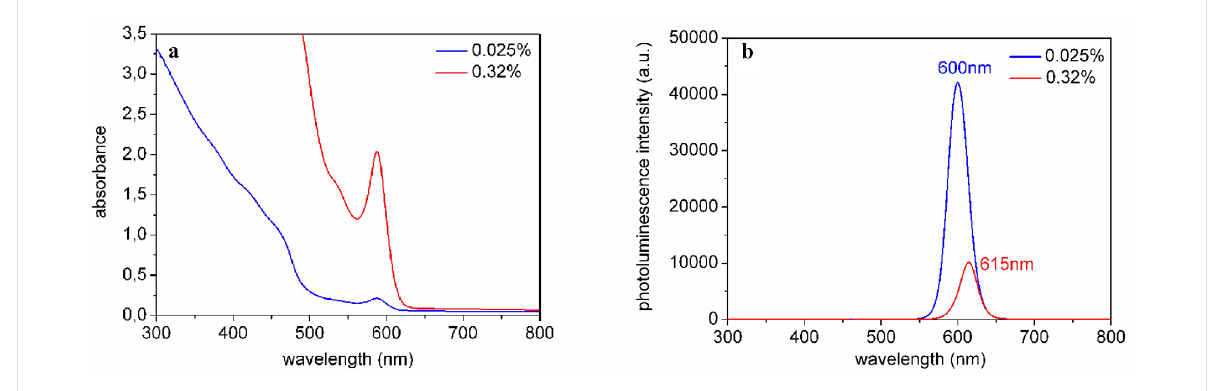
Figure 3: a) Absorption spectra and b) PL spectra of NRs (aspect ratio 6) in chloroform solution for different NR concentrations.